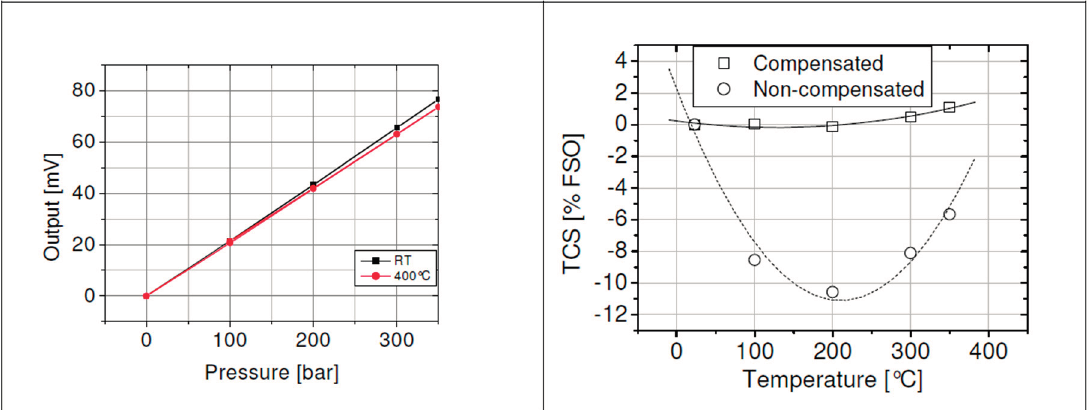
Figure 9. Left —Signal output over pressure of the packaged sensor at 25 °C and 400 °C (@ 0.5 mA) for pressure range up to 350 bar; Right —TCS (temperature coefficient of sensitivity) of the packaged sensor over temperature. Straight: Compensated package; dotted: Non-compensated package [8].